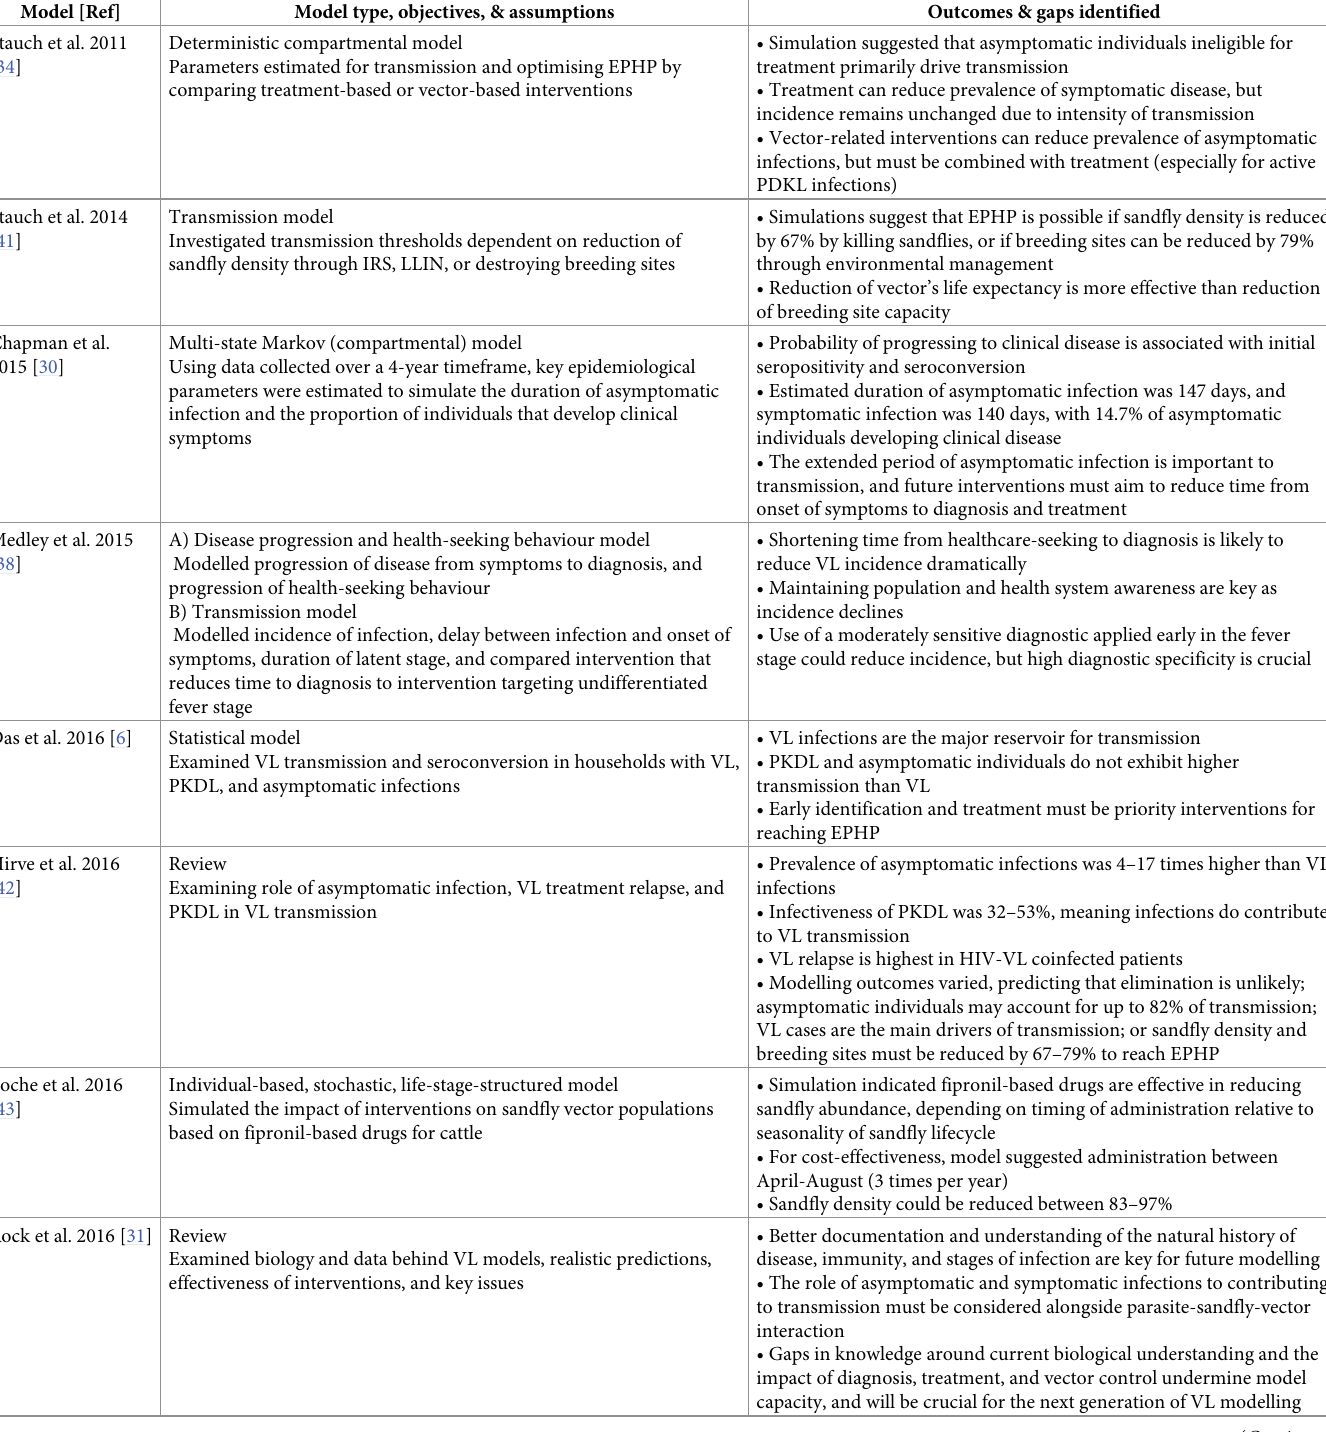
Table 1. Outline of key modelling studies on VL in the ISC by model type, objectives, assumptions, outcomes, and gaps identified. Model